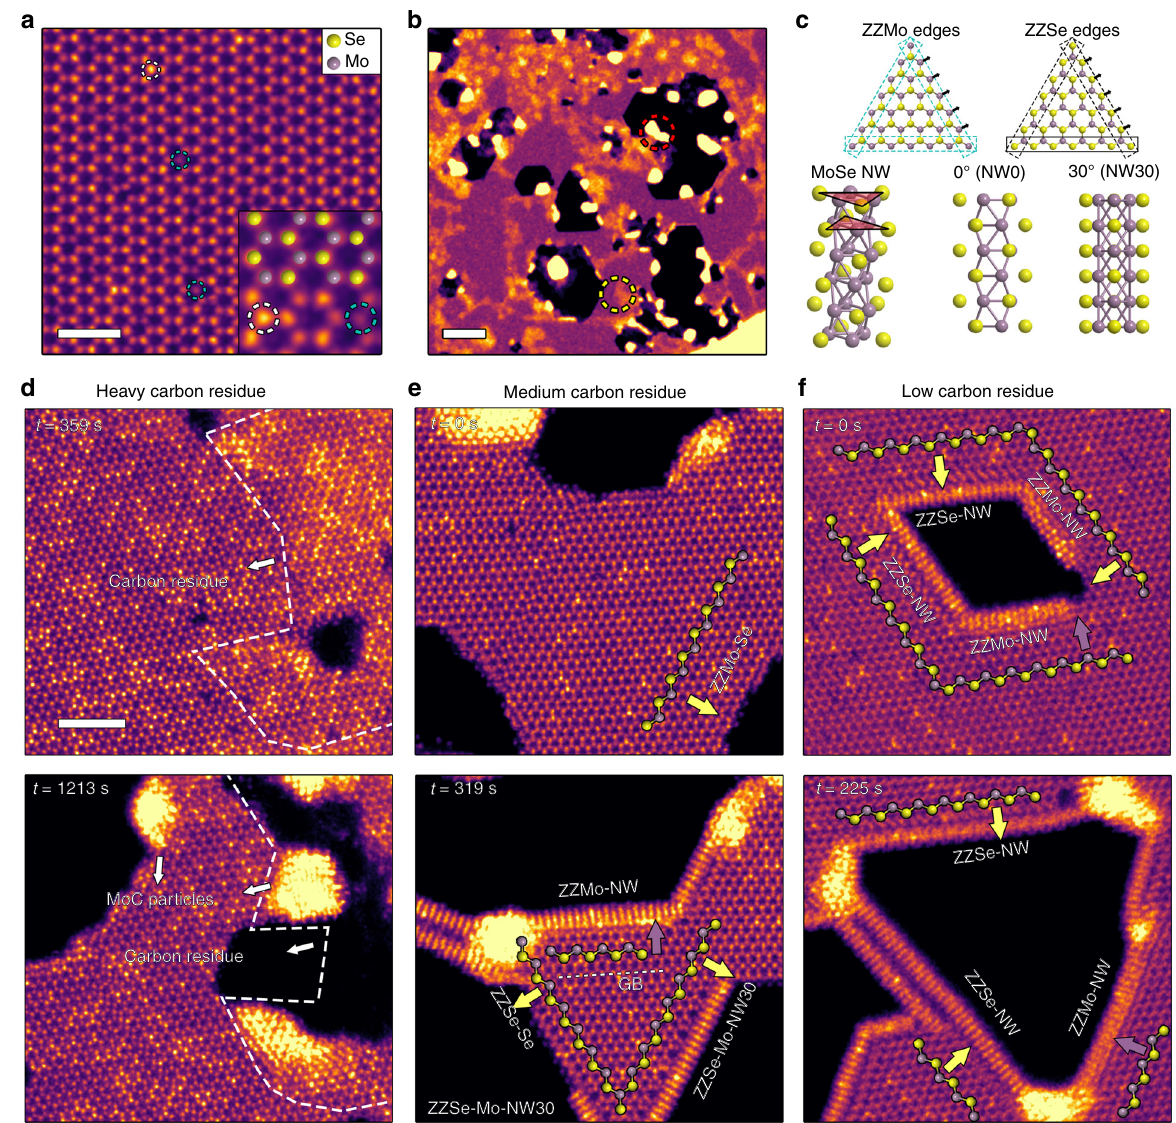
Fig. 1 In situ heating and etching of monolayer Mo 0.95 W 0.05 Se 2 with edge reconstructions. a Atomic resolution HAADF-STEM image showing the crystal structure of monolayer Mo 0.95 W 0.05 Se 2 . The white and cyan dashed circles indicate W dopants and Se vacancies, respectively. Inset: a structural model is overlaid on the HAADF-STEM image. Yellow, Se atoms; purple, Mo atoms. b Low magni fi cation HAADF-STEM image of monolayer Mo 0.95 W 0.05 Se 2 after in situ heating at 500 °C. The red dashed circle marks a MoC particle. The yellow dashed circle indicates carbon residue area with bright contrast. c (Top) atomic structure models of Mo-oriented ZZMo edges with Mo atoms pointing out normal to the edge (cyan dashed boxes) and Se-oriented ZZSe edges with Se atoms pointing out of the edge (black dashed boxes). (Bottom) atomic structure models of the MoSe NW formed on the edges and the two commonly-observed projections NW0 and NW30. d – f Atomic resolution HAADF-STEM images at initial and later stages of etching from areas with heavy ( d ), medium ( e ), low ( f ) carbon residue. Carbon residue and MoC nanoparticles are indicated by white arrows. ZZSe and ZZMo edges are indicated by white and purple arrows, respectively. Scale bars are 1 nm, 10 nm, and 2 nm for ( a ), ( b ), and ( d ), areas far from where the electron beam was rastered during heating (Supplementary Fig. 6), and since electron beam irra- diation at room temperature did not trigger their evolution 29 .